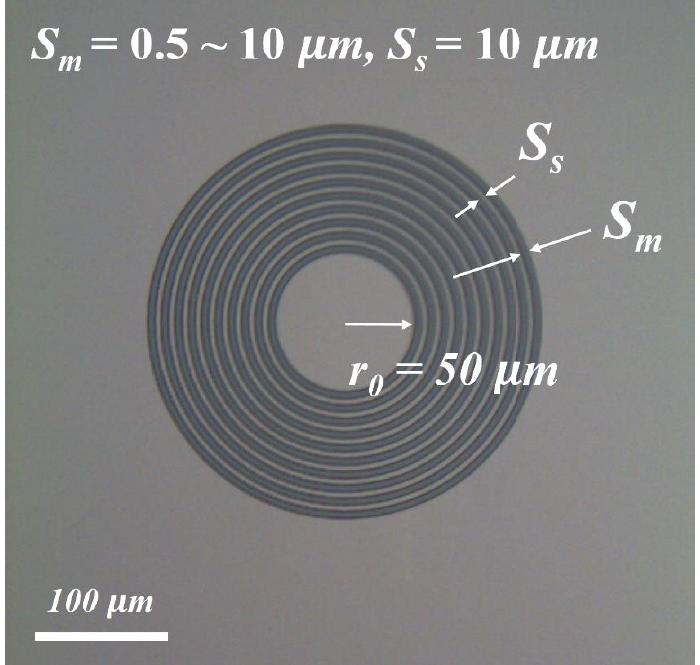
Figure 3. Top-view SEM image of the fabricated MR-CTLM structure.